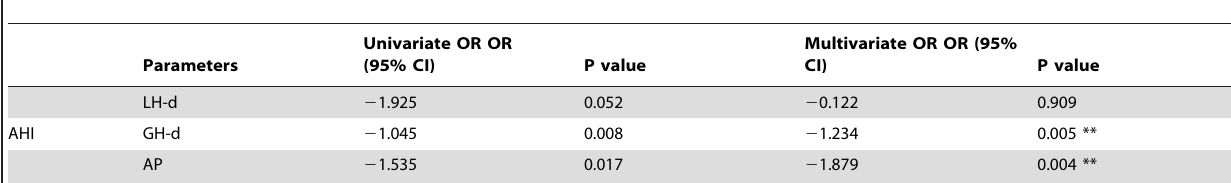
Table 3. Odds ratio of LH-d, GH-d, and AP for AHI by univariate and multivariate analysis.